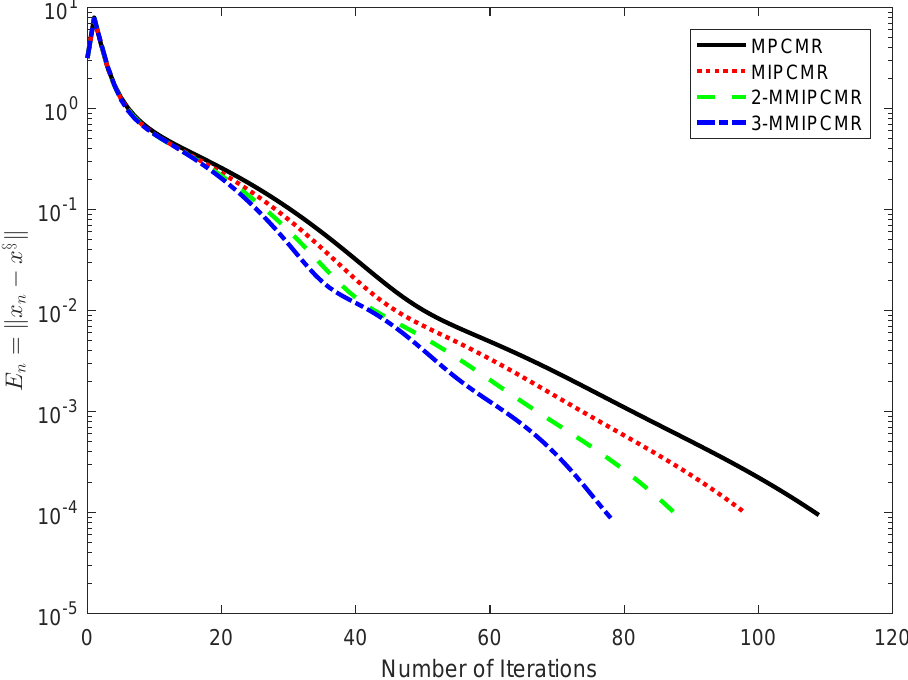
Figure 4. Comparison of MPCMR, MIPCMR, 2-MMIPCMR and 3-MMIPCMR in Example 2 with s =